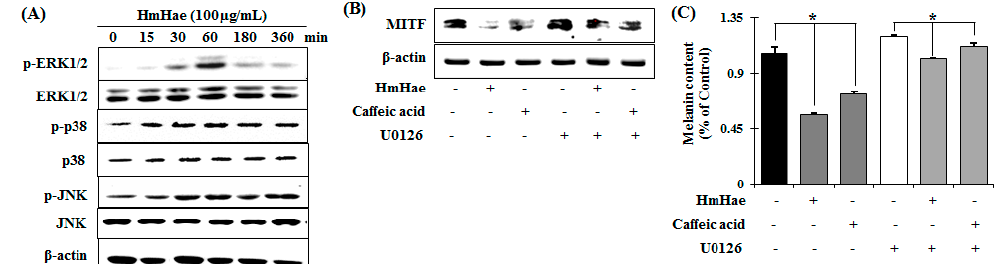
Figure 5. Effect of HmHae on mitogen-activated protein kinase (MAPK)-dependent signaling in melan-a cells. ( A ) Cells (5 × 10 5 cells/mL) were cultured for 24 h, and the medium was replaced with fresh medium containing various concentrations of test compounds at the indicated times.